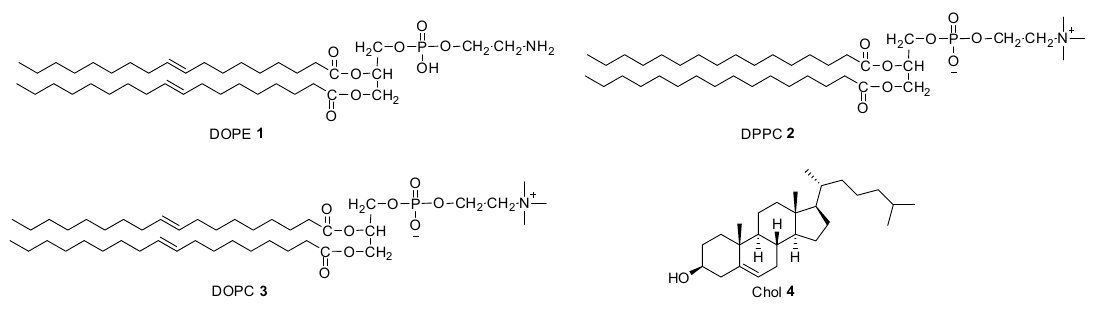
Figure 2. The structure of neutral auxiliary lipids.